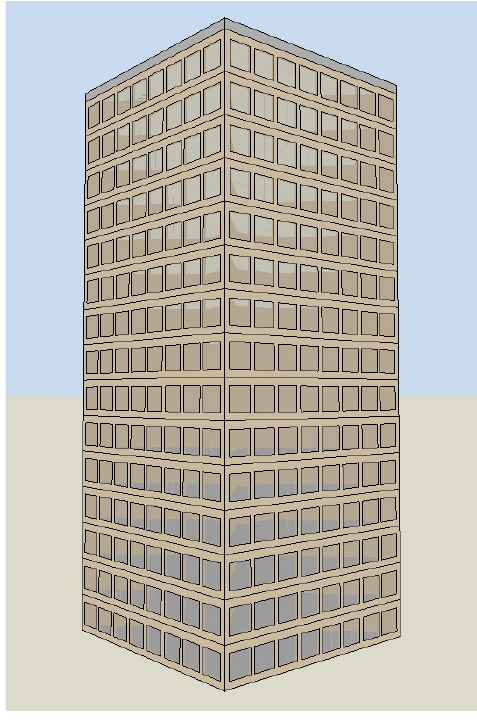
Figure 4 Rendered view of the case high-rise office